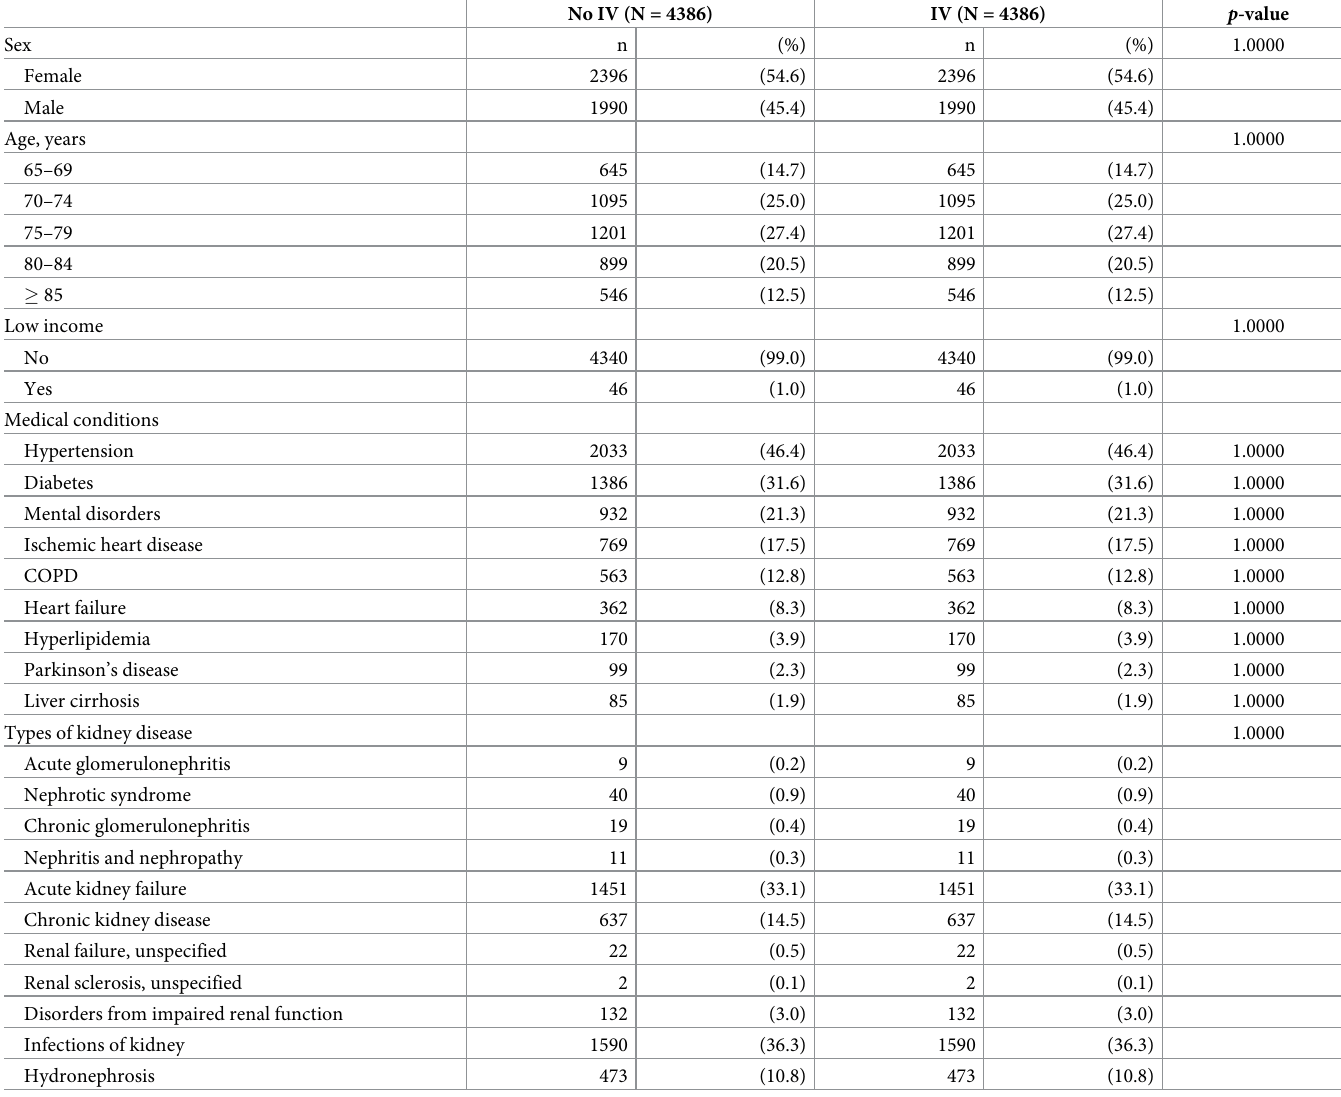
Table 2. Characteristics of hospitalized kidney disease patients with and without influenza vaccination (after propensity-score